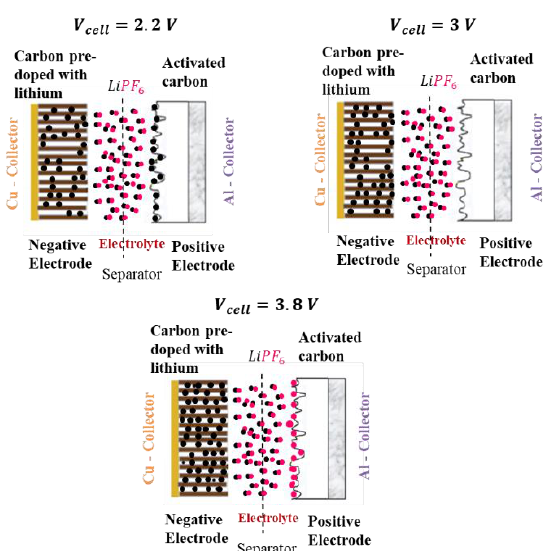
Figure 3. The chemical states of a LiC at 2.2 V ( E < E pzc ), 3 V ( E = E pzc ) and 3.8 V ( E > E pzc ).